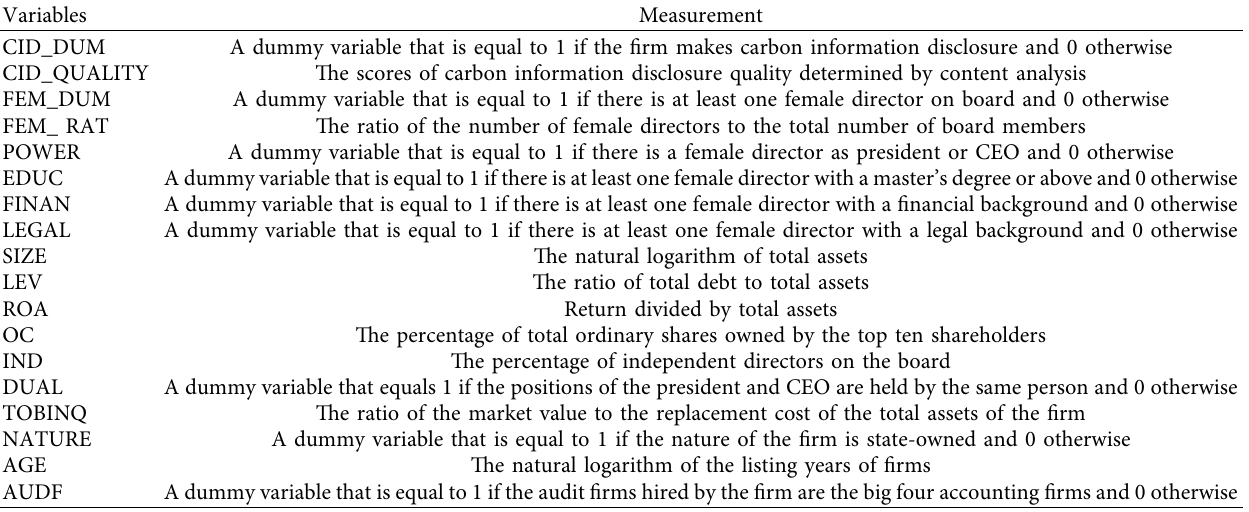
Table 4: Variable